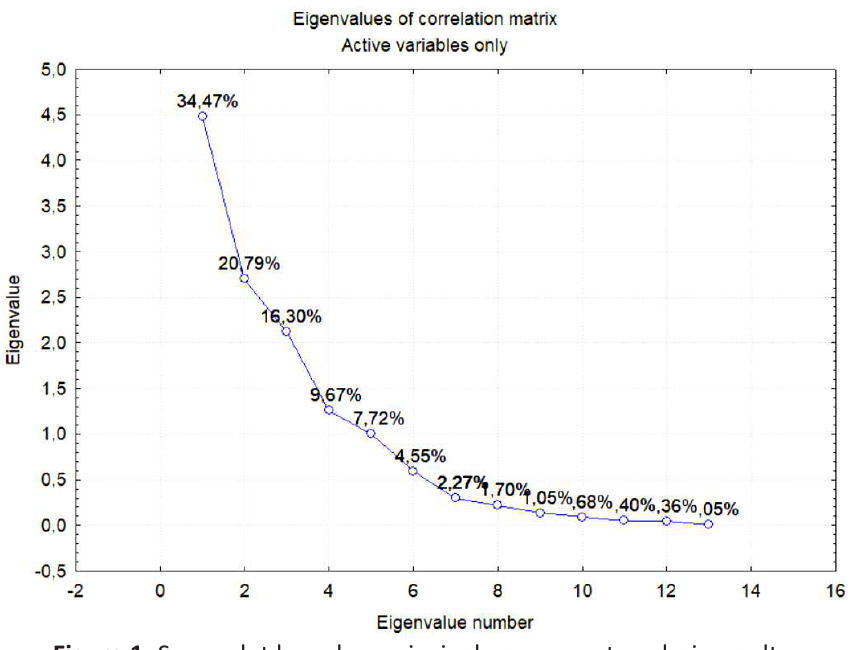
Figure 1. Scree plot based on principal component analysis results Table 1. Values of factors based on principal component analysis